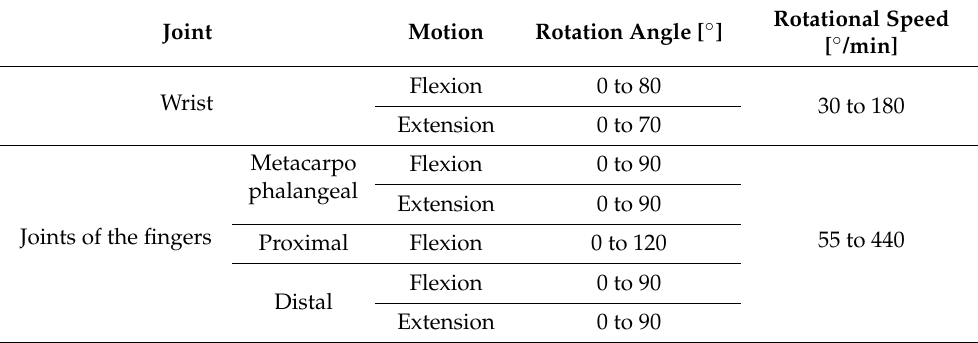
Table 1. Mobility characteristics of the wrist and finger joints.